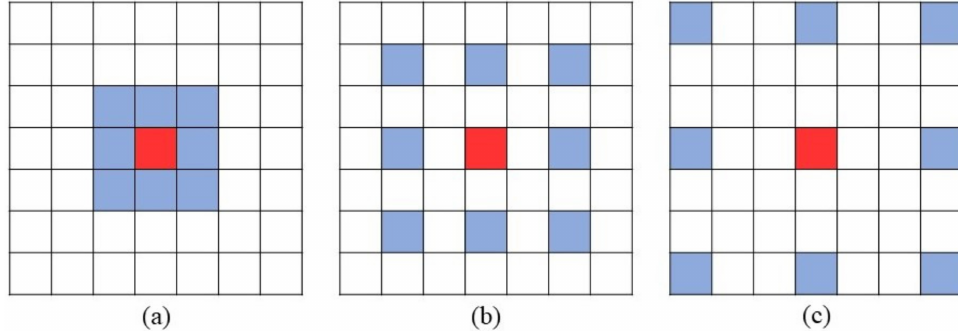
Figure 5. ( a – c ) Convolution kernels with different dilation rates of 0, 1, and 2, respectively.